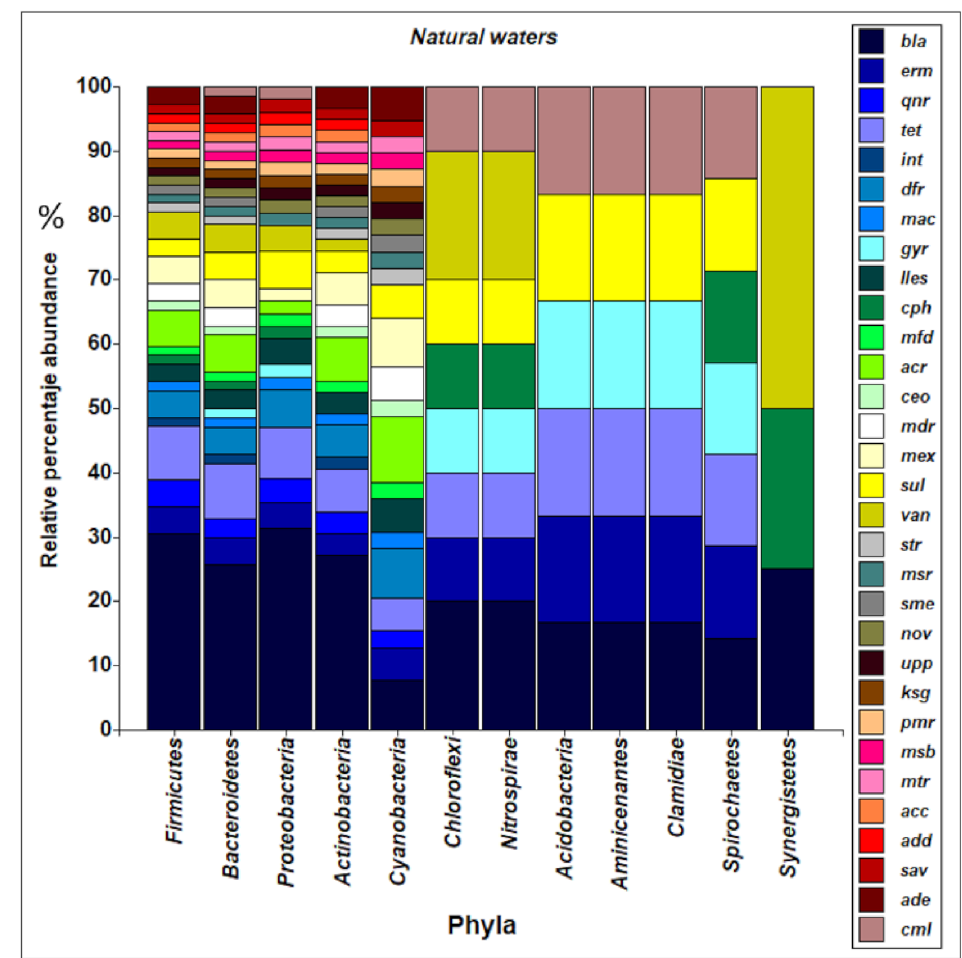
Figure 8. Abundance and diversity of ARG and bacterial taxa present in natural water. bla (gene with resistance to betalactamase), erm (gene with resistance to erythromycin), qnr (gene with resistance to quinolones), tet (gene with resistance to tetracycline), int (integron), dfr (gene with resistance to trimethoprim), mac (gene with resistance to macrolides), gyr (gene encoding a subunit of DNA gyrase), iles (gene with resistance to quinolones), cph (gene with resistance to imipenem), mfd (Mutation- Frequency-Decline: onfers resistance to the host nitrogen immune response), acr ( gene that codes for acrosin), ceo (gene with resistance to cefoperazone), mdr (The multiple drug resistance gene mdr encodes the so-called P-Glycoprotein), mex (gene with resistance to tetracycline), sul (gene with resistance to Sulfamethazine), sul (gene with resistance to Sulfamethazine), van ( gene with resistance to vancomicine), str (gene with resistance to streptomycin), msr (gene with resistance to macrolides, lincosamides and streptogramins), sme ( gene with resistance to carbapenems), nov ( gene with resistance to novobiocine) upp (Uracil fosforribosiltransferasa), ksg (Serine/threonine-protein kinase), pmr (gene with resistance to peptide antibiotic), msb (gene with resistance to nitroimidazole antibiotic), mtr (gene with resistance to penam, macrolide antibiotic), acc (gene with resistance to penam), add (gene with resistance to kanamycin), sav (efflux pump), ade (gene with resistance to tetracycline and glycylcycline), cml (gene with resistance to